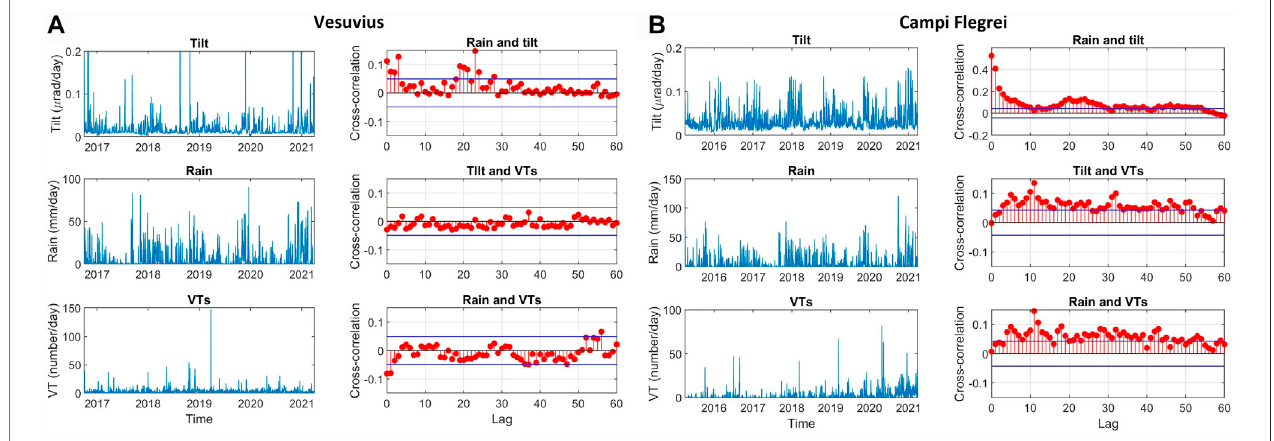
FIGURE 3 | (A) On the left, daily values of RMS tilt, rainfall and earthquake number for Vesuvius. On the right, cross-correlation functions among the three time series (lag (cid:1) 1 corresponds to 1 day). The blue horizontal lines mark the con fi dence limits (95%), above which the correlation between the time-series is considered signi fi cant. (B)